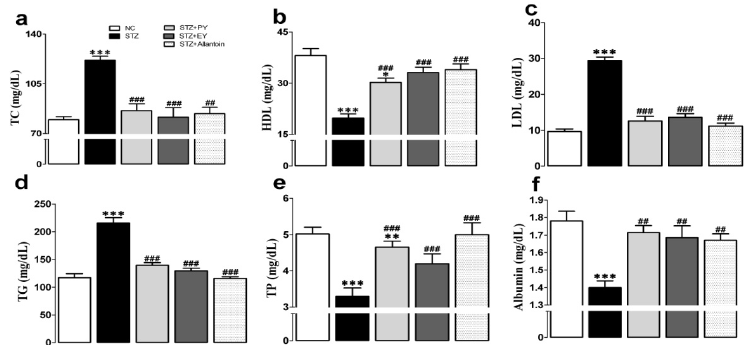
Figure 4. Effects of PY, EY, and allantoin treatments on serum lipid and protein profiles in STZ ‐ induced diabetic rats. TC, total cholesterol (a); HDL, high density lipoprotein (b); LDL, low density lipoprotein (c); TG, triglyceride (d); TP, total protein (e); Albumin (f). Data are reported as means ± SEMs ( n = 10). *: p < 0.05; **: p < 0.01; and ***: p < 0.001, Bonferroni post hoc test following one ‐ way ANOVA versus the NC group (Cont); # : p < 0.05; ## : p < 0.01; and ### : p < 0.001, Bonferroni post